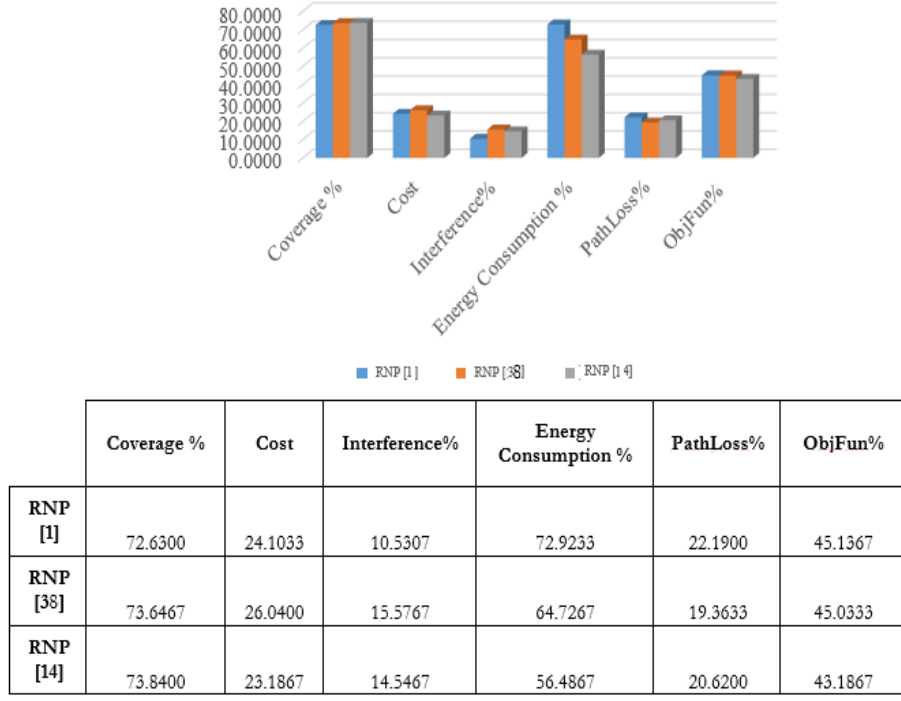
Fig. 19. Improvement % of the RNP model for different objective functions of the existing RNP